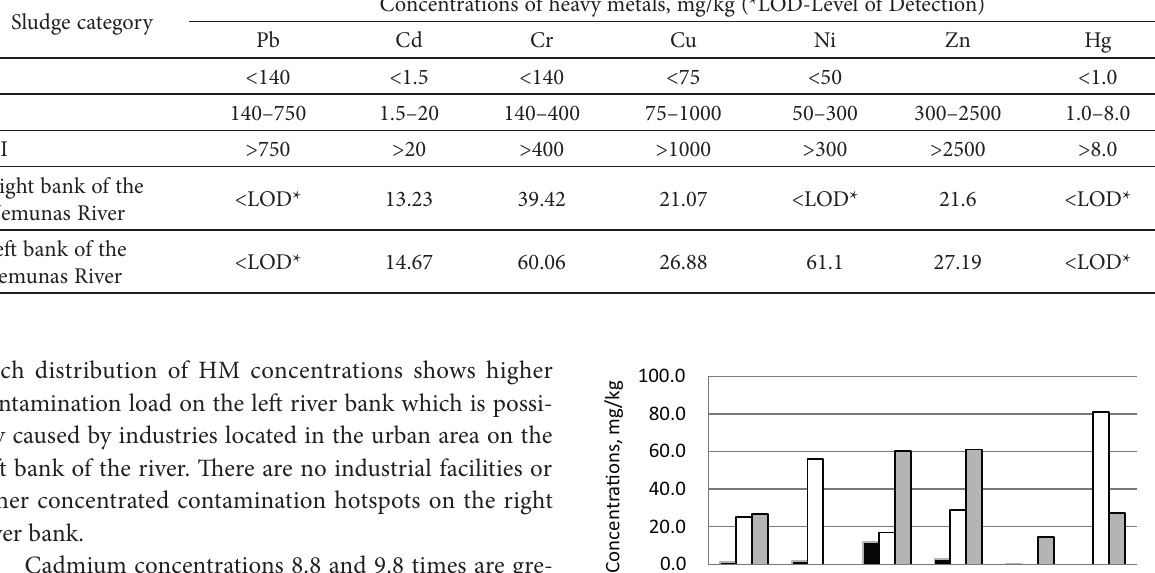
Table 2. Sludge categorization by HM concentrations (LAND 20-2005) Sludge category